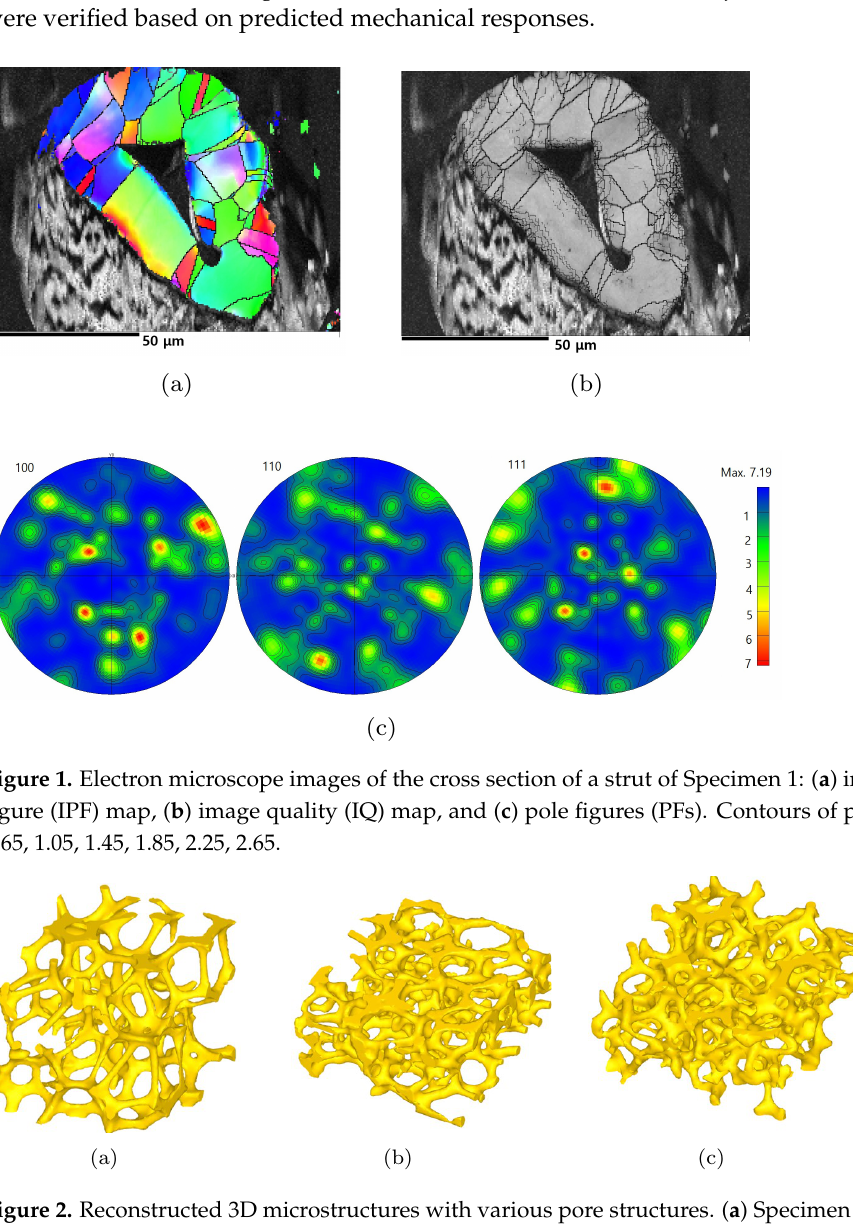
Figure 2. Reconstructed 3D microstructures with various pore structures. ( a ) Specimen 1 (2.05 mm Figure 2: Reconstructed 3D microstructures with various pore structures. (a) Specimen 1 high), ( b ) Specimen 2 (1.05 mm high), and ( c ) Specimen 3 (1.03 mm (2.05 mm high), (b) Specimen 2 (1.05 mm high), and (c) Specimen 3 (1.03 mm high)